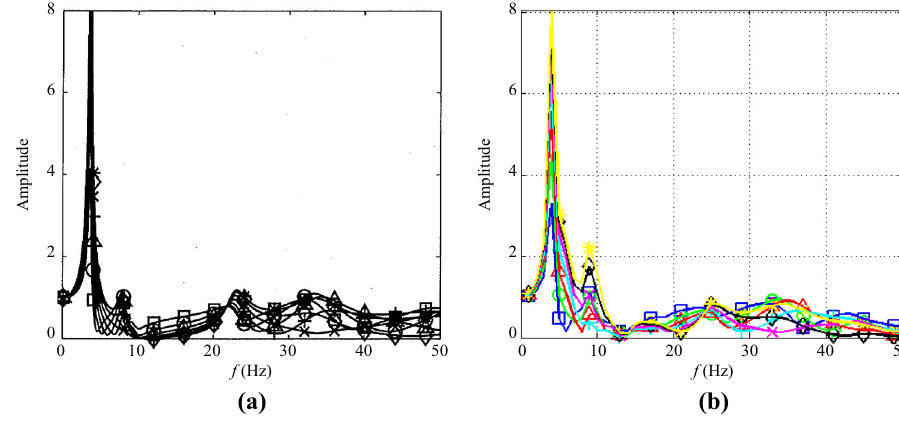
Fig. 12 Soil–building transfer functions of the office tower: a prediction model and b finite-element